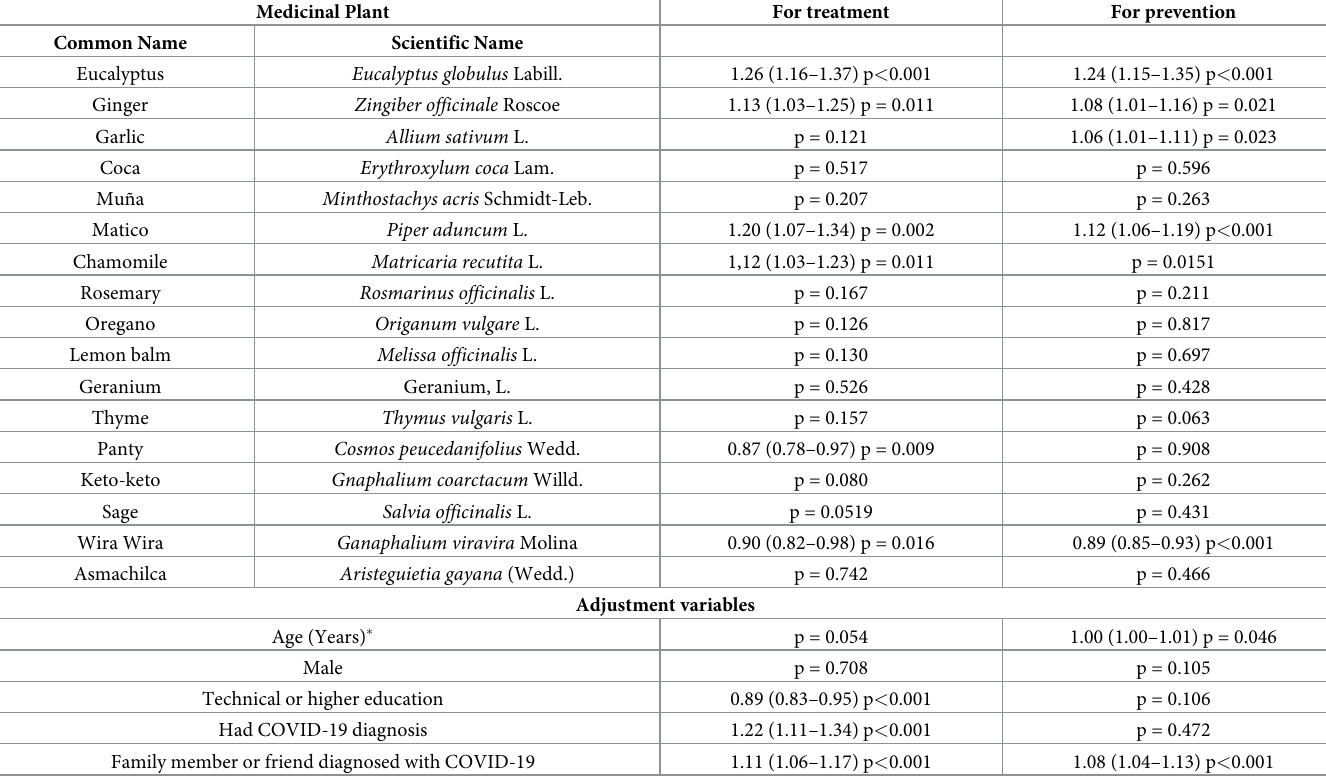
Table 4. Multivariate analysis of the use of medicinal plants for the treatment or prevention of respiratory symptoms during the COVID-19 pandemic in Cusco, Peru. Medicinal Plant For